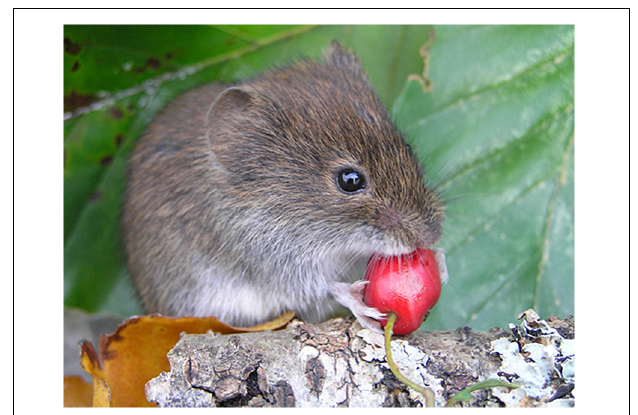
FIGURE 1 | The bank vole Clethrionomys glareolus , an emerging “non-model model” species for evolutionary and ecological research. Image credit: PK.